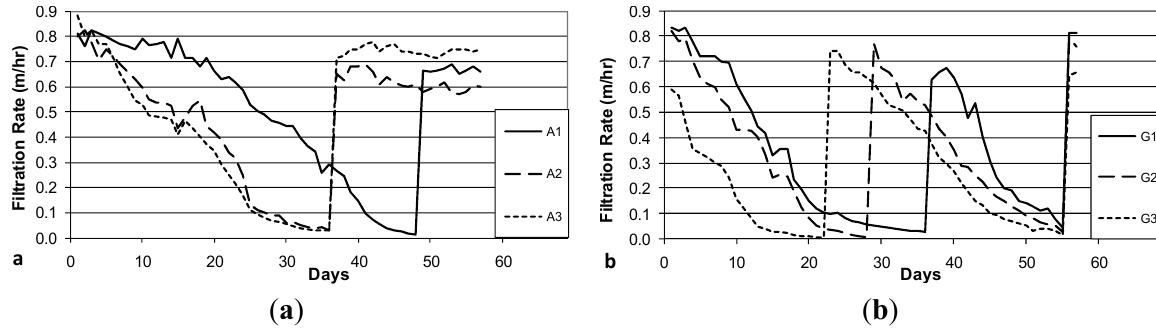
Figure 4. Initial daily filtration rate during Column Test No. 1. Accusand-loaded filter columns A1-A3 ( a ); and Granite-loaded filter columns G1-G3 ( b ). Spikes in filtration rate are due to either intentional removal (cleaning) of the schmutzdecke (A1 day 39, A2 day 29, G1 day 47) or unintentional disturbance of the schmutzdecke during filter loading (A3 day 17, G3 day 41).